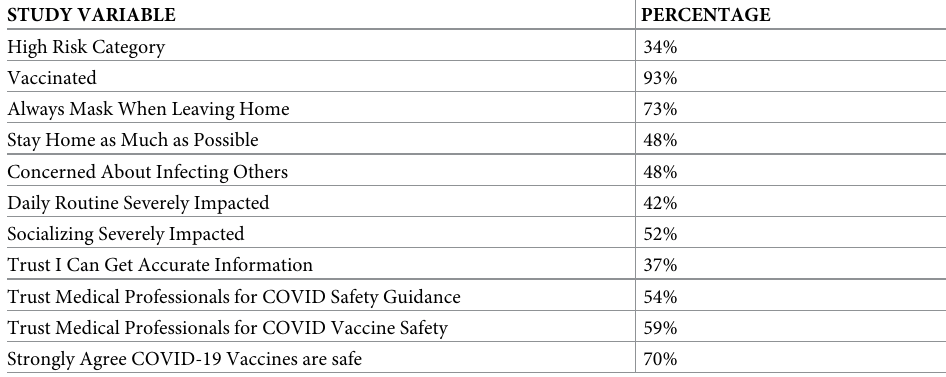
Table 2. COVID behaviors and beliefs of sample (N =